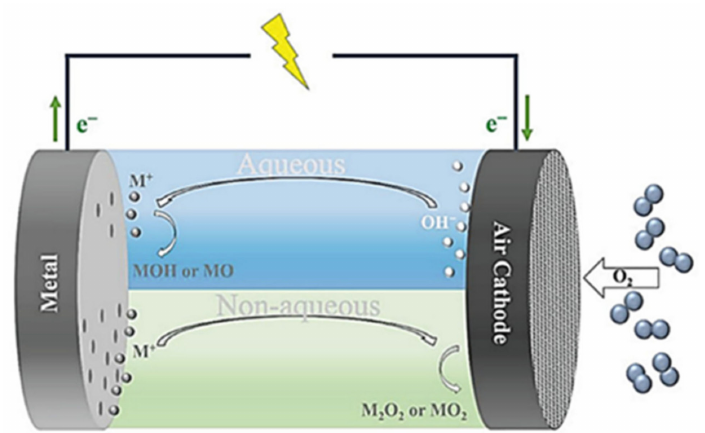
Figure 8. Schematic representation of metal–air batteries with aqueous (upper, blue) and nonaqueous (below, green) electrolytes. Adapted from [39]. Copyright (2021) MDPI. This article is an